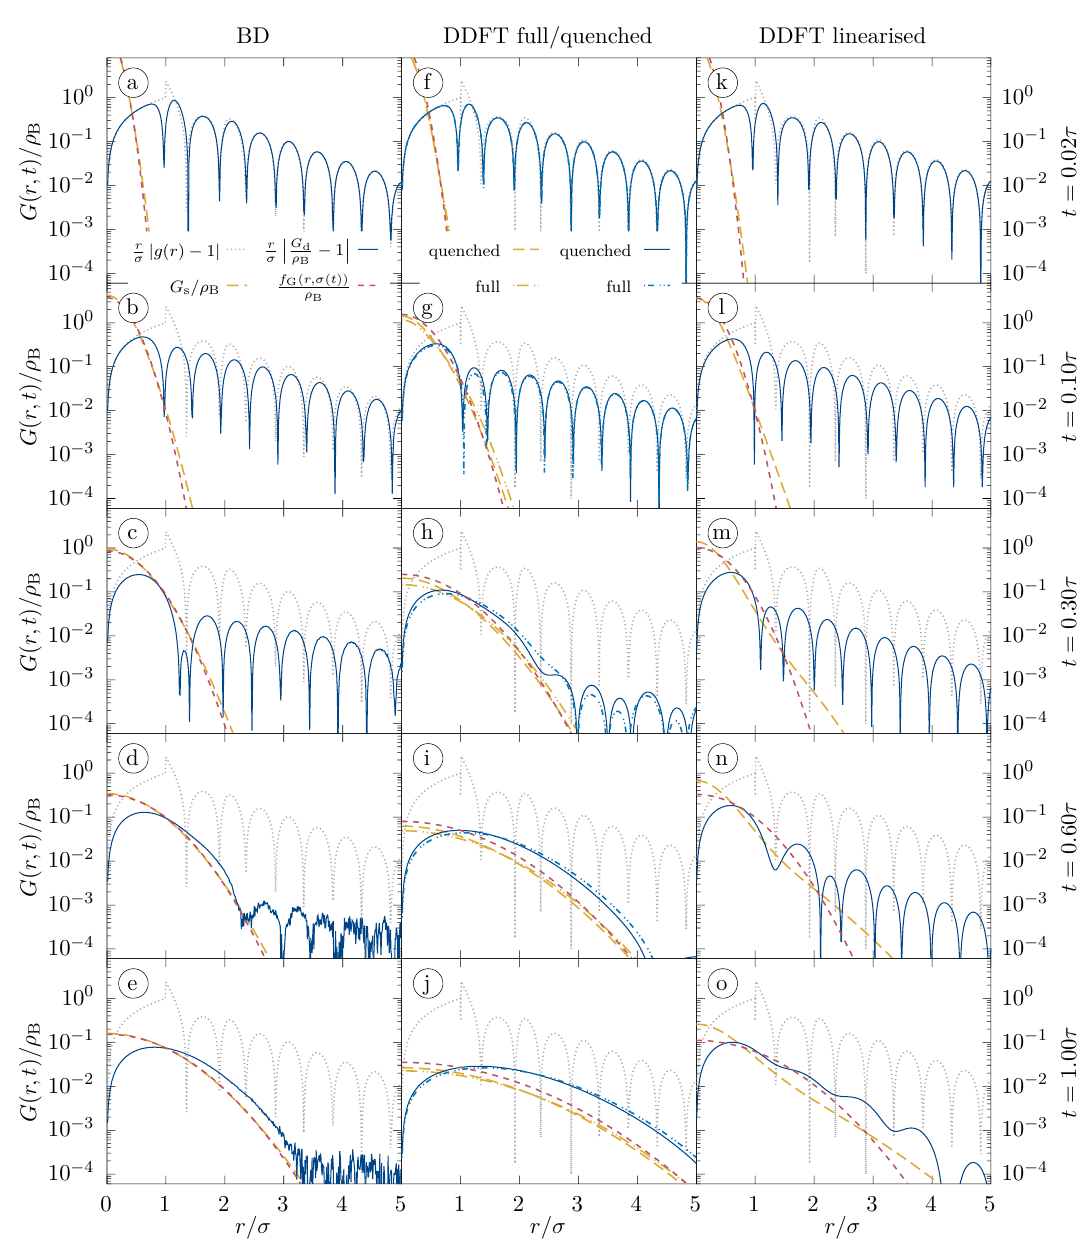
Figure 2: Self (yellow dashed lines) and distinct (solid blue lines) part of the van Hove correlation function G ( r , t ) at different times t , with radial distribution function ( r , σ ( t )) (dash-dotted red lines) with mean g ( r ) (dotted grey lines) and Gaussian f G (cid:10) (cid:11) = r 2 square displacement 3 σ 2 fitted to match that of the self correlation. Results from BD (left column, panels (a) – (e)) are compared to DDFT with full and quenched excess free energy functional (middle column, panels (f) – (j)) and to DDFT with partially linearised excess free energy functional (right column, panels (k) – (o)). The maxima of the solid line correspond to the local extrema of the distinct van Hove ( r , t ) /ρ − 1 | always corresponds to a minimum function. The first maximum of r | G d B ( r , t ) of G d